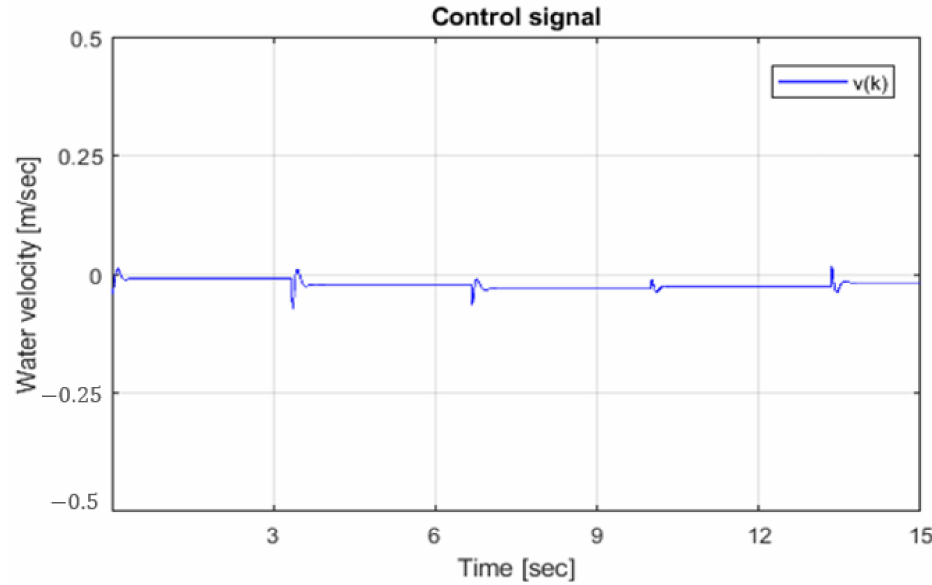
Figure 10. MPC control signal; water velocity v ( k ) (m/s )